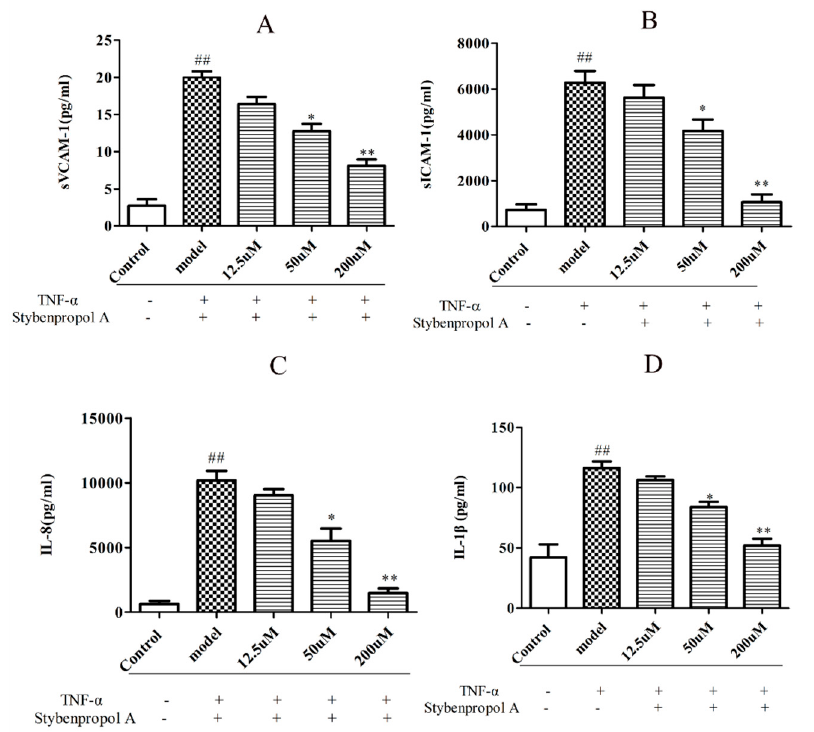
Figure 5. Stybenpropol A suppressed inflammation induced by TNF- α in HUVECs. Following a 24 h pretreatment with stybenpropol A (12.5, 50, 200 µ M), HUVECs were treated with TNF- α for 12 h and levels of sVCAM-1( A ), sICAM-1( B ), IL-1 β ( C ), and IL-8 ( D ) were measured via ELISA. Data are means ± SD of three independent experiments. ## p < 0.01 vs. control; ∗ p < 0.05, ∗∗ p < 0.01 vs. model group.